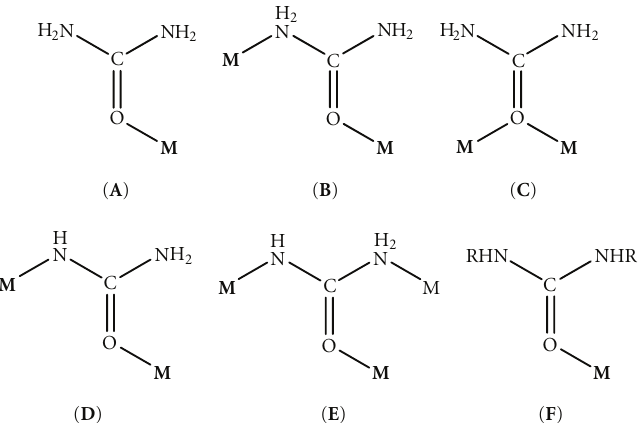
Scheme 2: The crystallographically established coordination modes of urea (U) and its symmetrically substituted alkyl derivatives